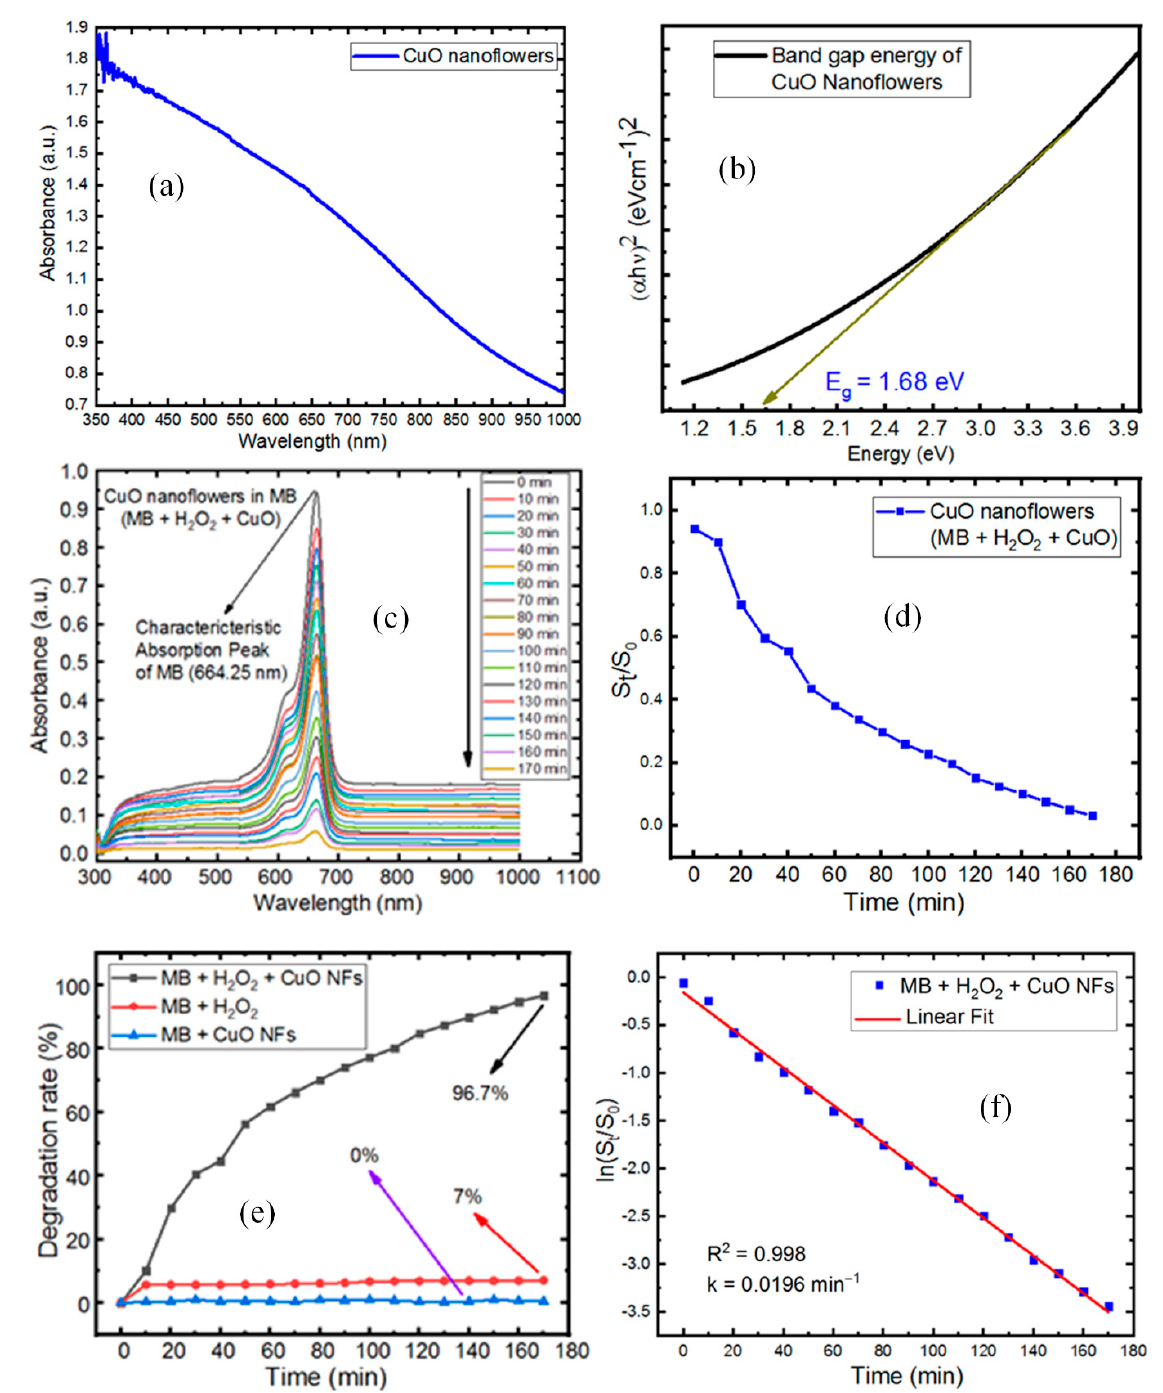
Figure 6. UV–visible absorption, energy band gap and degradation of MB dye solution in dark. ( a ) UV–visible absorption CuO nanoflowers; ( b ) Band gap of copper oxide nanoflowers; ( c ) Time profile degradation of MB + H 2 O 2 + CuO; ( d ) Time profile concentration ratio plot of MB + H 2 O 2 + CuO; ( e ) % Degradation of MB dye in CuO NFs, H 2 O 2 and H 2 O 2 + CuO NFs ; ( f ) Plot of ln(S t /S o ) versus t (time).